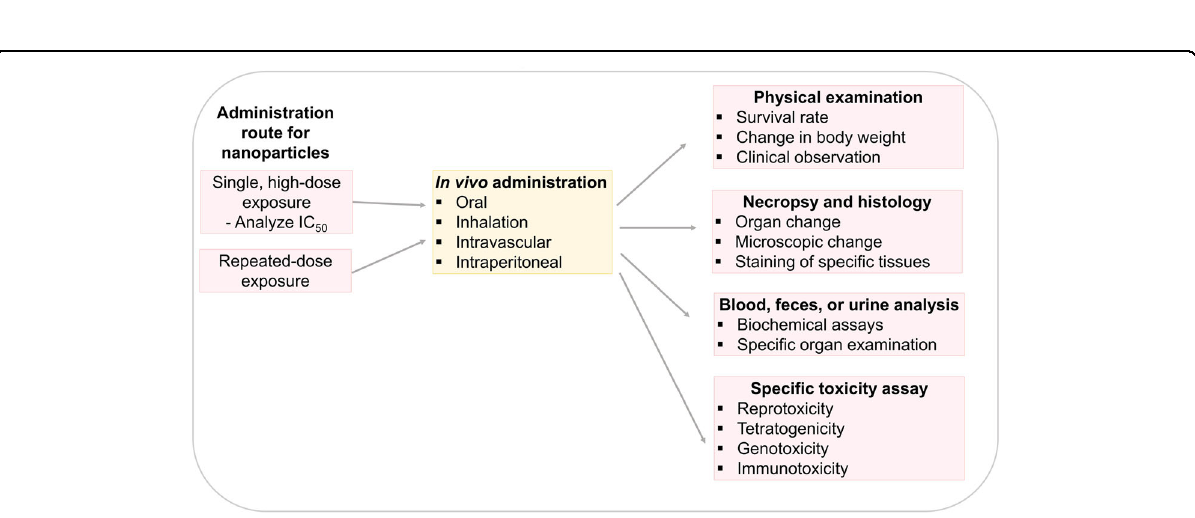
Fig. 19 Schematic diagram of the toxicology assay in vivo. After in vivo administration of nanoparticles with the certain dose, the toxicity of nanoparticles can be assessed from physical examination, change in tissues, pharmakokinetic change, and speci fi c toxicity